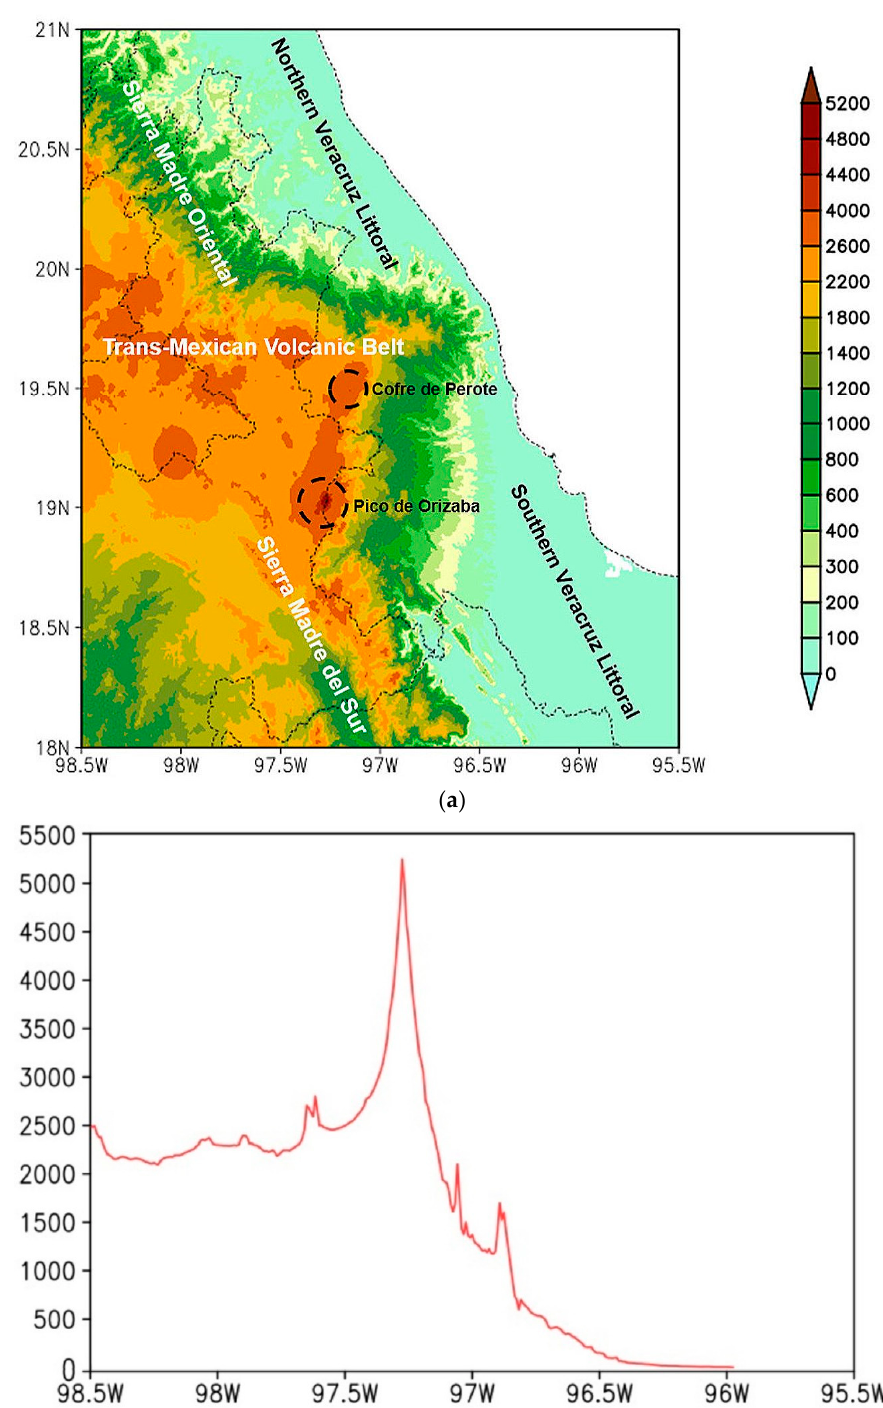
Figure 1. ( a ) Topography of the region VCZ (see text for further explanation); and ( b ) cross-section of the topography on 19° N. The same scale of values in meters above sea level (m.a.s.l.) in both figures.